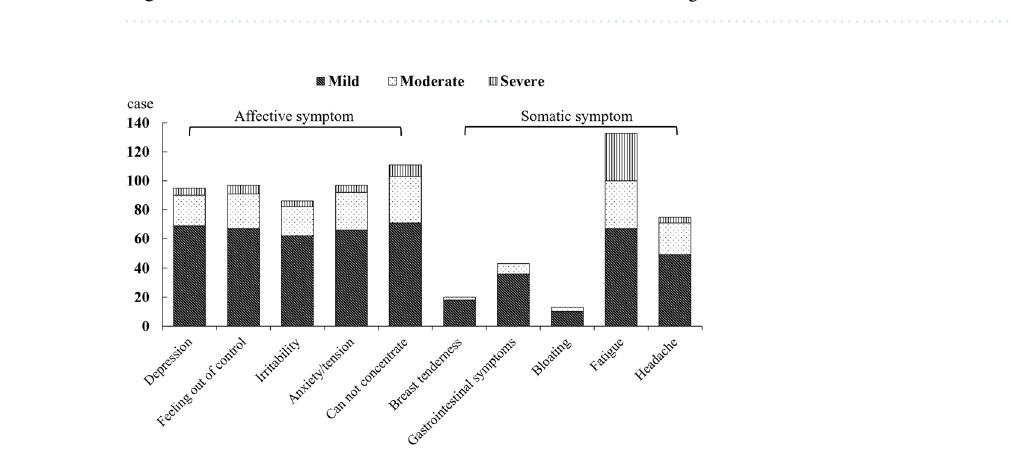
Figure 2. The incidence of PMS in female students of senior high school.